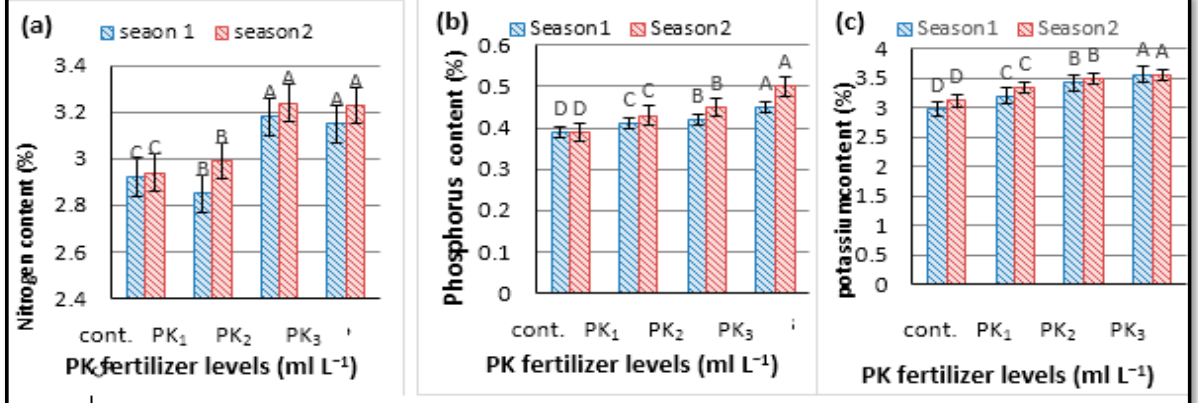
Figure 6. Head minerals contents (mean ± SE) of globe artichoke as affected by the PK fertilizer levels (Control: without, PK1: 25, PK2: 50 and PK3: 75 mL L − 1 ) on ( a ) Nitrogen content (%); ( b ) Phosphorus content (%) and ( c ) Potassium content (%). Letters in the figures indicate that the mean ± SE treatments with the same letters were not significantly different according to Duncan’s multiple range test for p < 0.05.